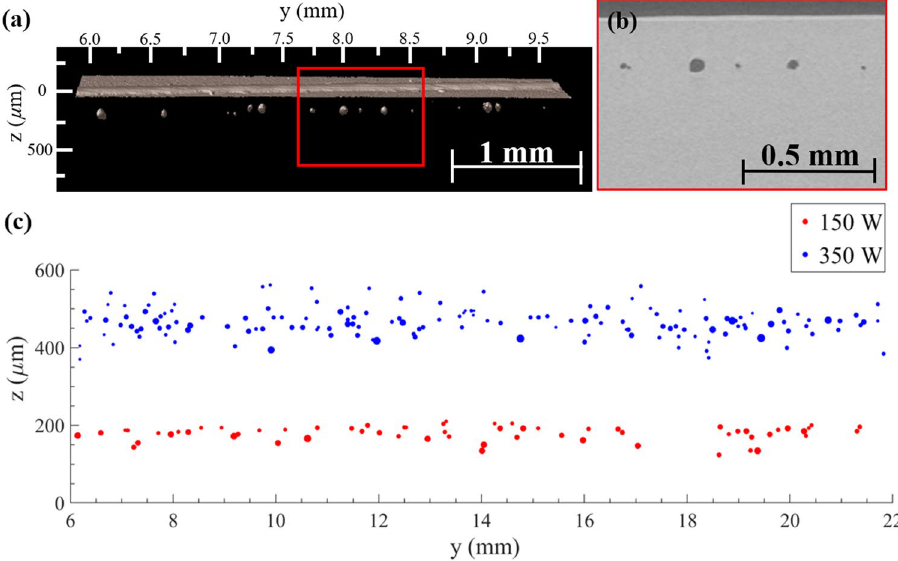
Figure 7. ( a ) A view of the X-ray CT reconstruction of the 150 W sample in the range y = 6.00–9.78 mm. The red box outlines the sectioned view shown in (b). ( b ) A 2D slice through the YZ plane of the X-ray CT reconstruction. ( c ) The sub-surface void locations for the 150 W and 350 W Ti-6Al-4V samples found with X-ray CT. Described by the void location along the track (y (mm)), void depth below the track line (z ( µ m)), and void diameter (d ( µ